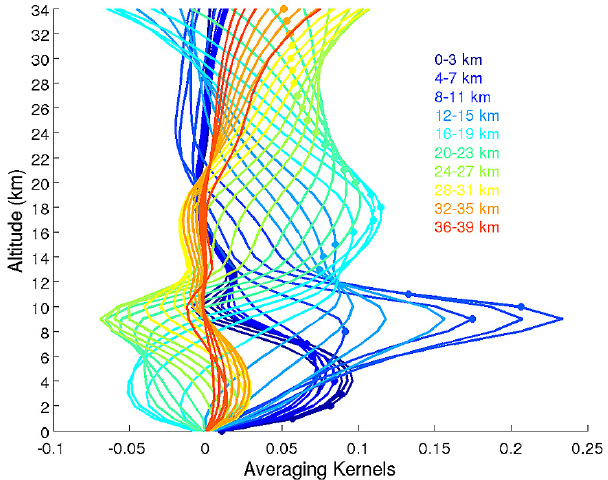
Fig. 3. Averaging kernel functions for different altitudes from FORLI-O 3 retrievals (DOFS=3.3) at 63.7 ◦ N, 20.4 ◦ W, on 17 July